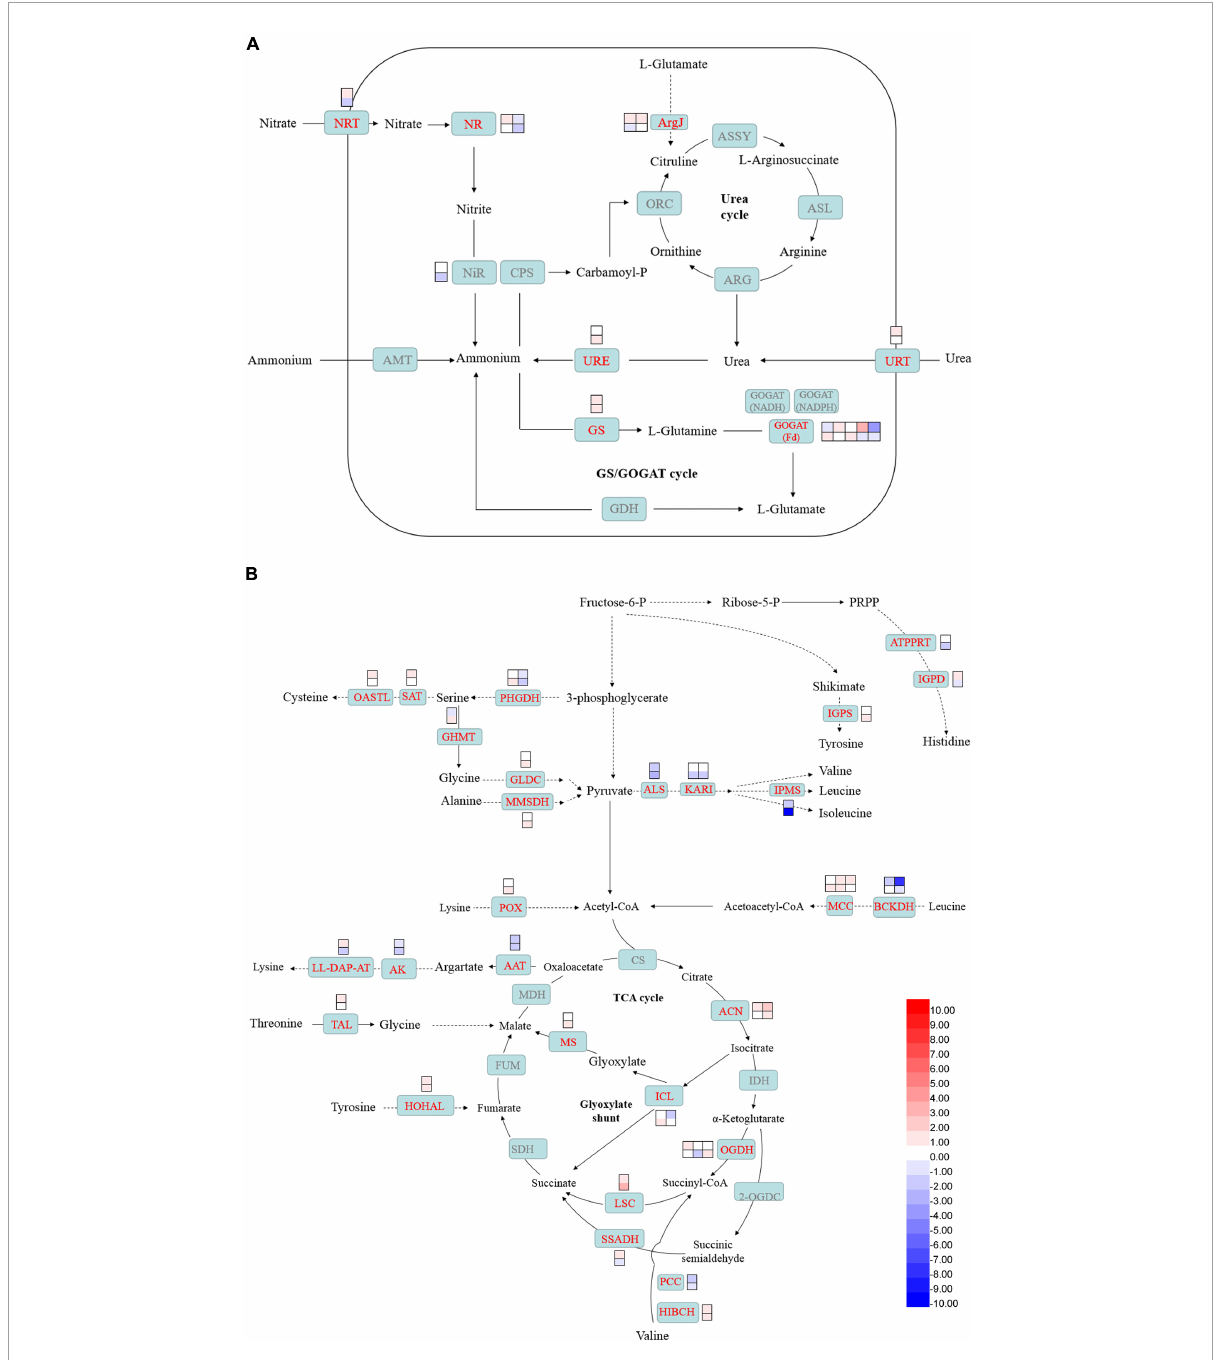
FIGURE7 Changes in nitrogen assimilation and amino acid catabolism under CHES treatment in P. tricornutum . The expression of genes participating in nitrogen assimilation (A) and amino acid metabolism (B) were determined by RNA-seq in 2 and 3 days after culture. The upper and lower panels were determined in 2 and 3 days after culture,